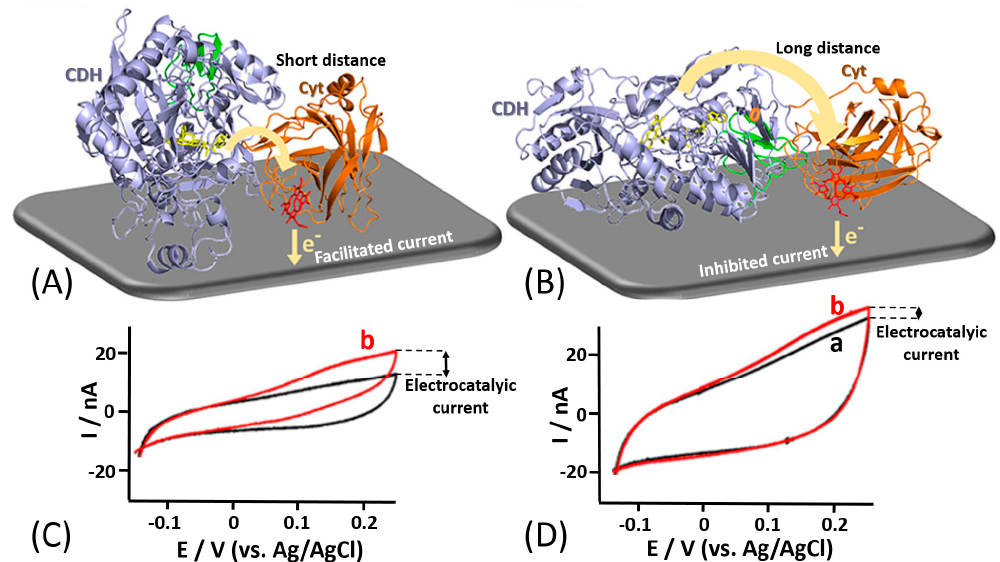
work to immobilize Mt CDH variants with a single surface exposed cysteine, with the different components in different colors. ( F ) Background-corrected catalytic currents at 0.0 V vs. SCE for the four Mt CDH variants from parts (A–D) plotted as a function of the glucose concentration. The definition of all used mutants and their abbreviate names can be found in ref. 167. (The figure was adopted from ref. 167 with permission.).